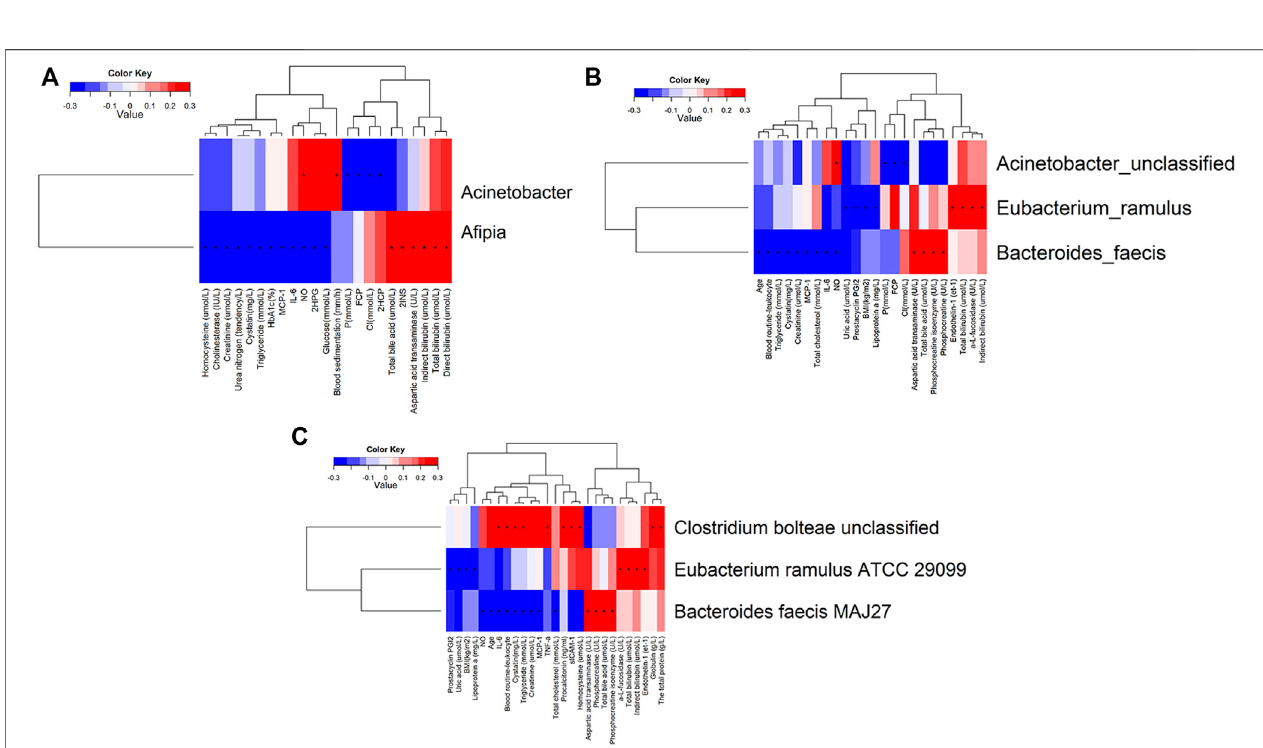
FIGURE8| Correlationanalysisofsigni fi cantlydifferent clinicalindicatorsand differentialbacteriaat levels ofgenus (A) ,species (B) and strain (C) in type2 diabetic patients.